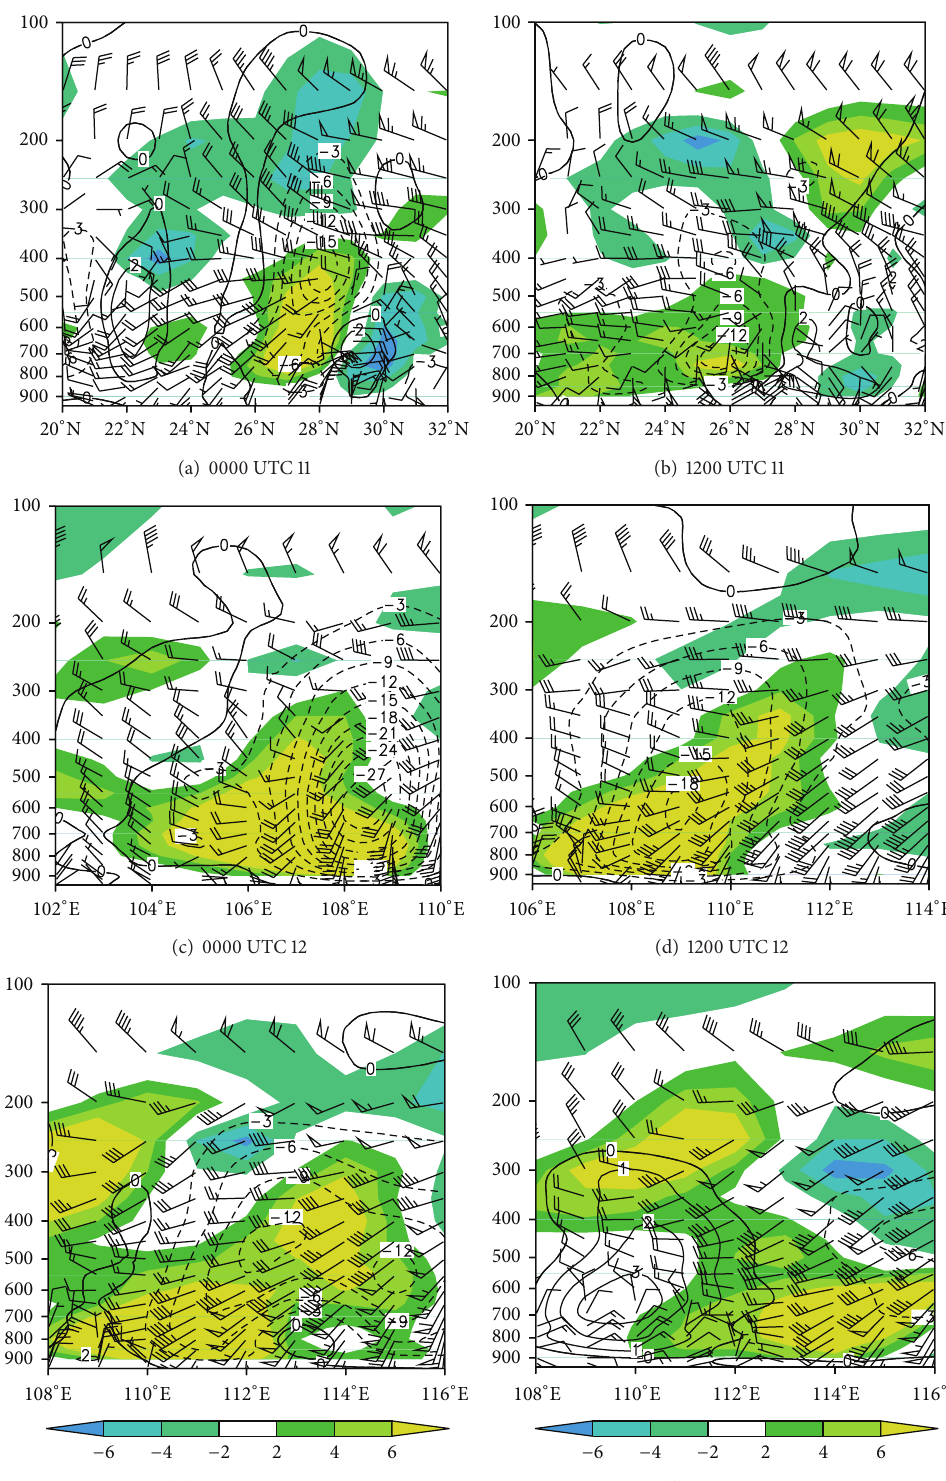
Figure 5: Vertical distribution of wind and vertical vorticity distribution ( × 10 −5 s −1 ) (colored areas indicate vorticity; solid lines indicate vertical velocities in the unit of × 10 −1 Pa/s; horizontal wind speed is in the unit of m/s) at the sections along (a) 104 ∘ E; (b) 105 ∘ E; (d) 24 ∘ N; and (c, e, and f) 25 ∘